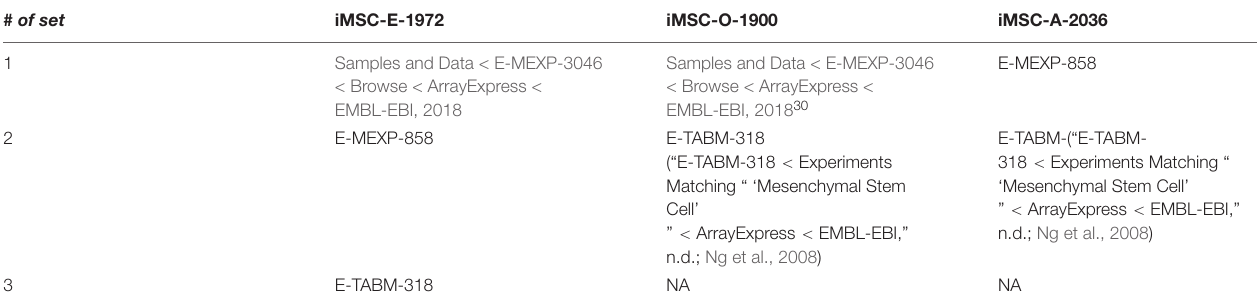
TABLE 1 | List of data sets used to create the computational